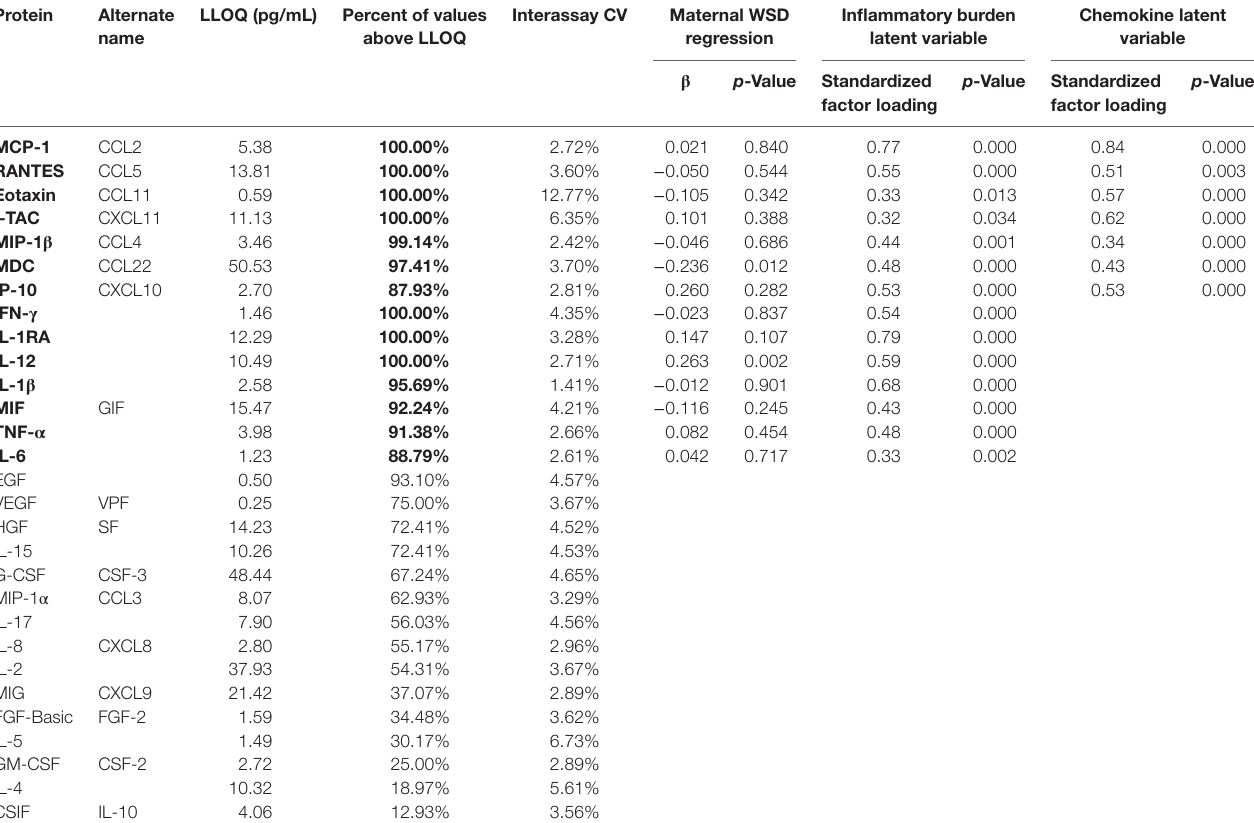
TaBle 2 | Third trimester inflammatory